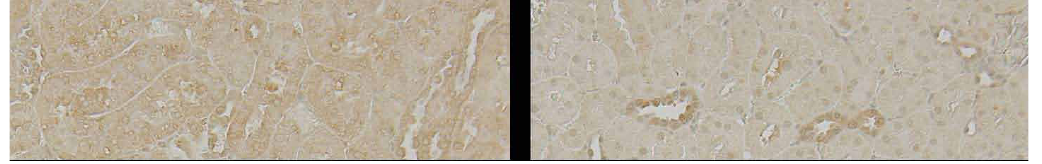
Left: Group 2: Micro-vacuolar changes and TGF-beta positive deposits are observed in the proximal tubules; Right: Group 3: Both of them are not